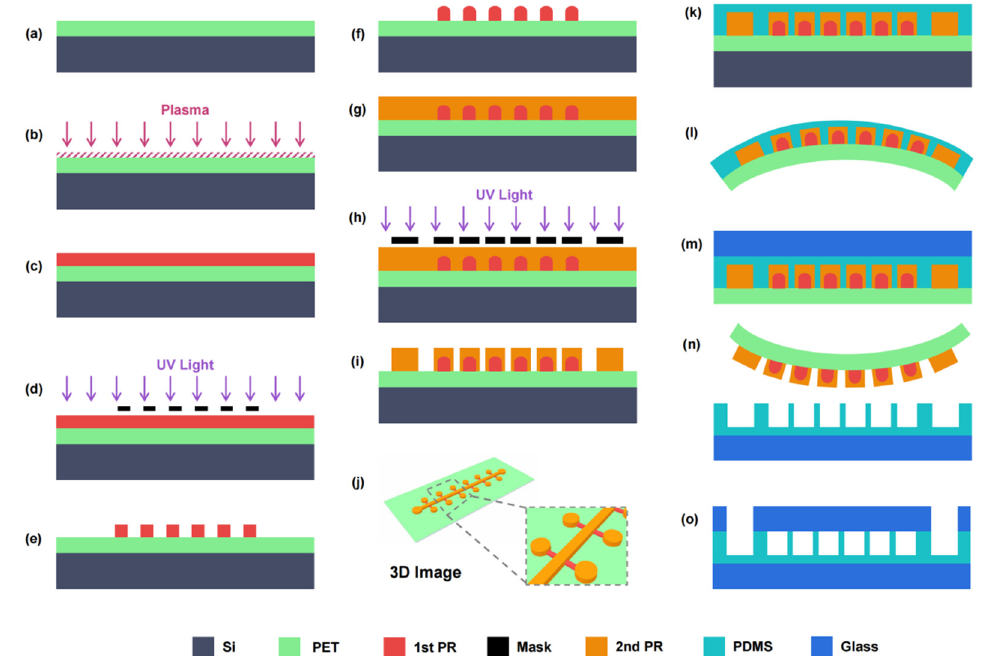
Figure 1. A fabrication process of the G-P-G MFD with an ultra-thin patterned PDMS film by a flexible soft mold peel-off process: ( a ) PET film attached to a 4-inch silicon wafer. ( b ) Oxygen plasma treatment on the PET surface. ( c ) First AZ 4620 PR layer with a height of 15 μ m spin-coating. ( d , e ) Exposing and developing to form branch channel structures. ( f ) First AZ 4620 PR layer reflowing. ( g ) Second AZ 4620 PR layer with a height of 30 μ m spin-coating. ( h , i ) Exposing and developing to form main channels and chamber structures. ( j ) A 3D image of the flexible mold. ( k ) A 10:1 mixture of PDMS spin-coating. ( l ) A flexible mold with PDMS film detaching from the rigid wafer. ( m ) Oxygen plasma bonding between PDMS surface and a cover glass. ( n ) Flexible mold peel-off from the PDMS film–glass structure. ( o ) Oxygen plasma alignment bonding between a rigid glass–PDMS film structure and a laser-drilled glass.